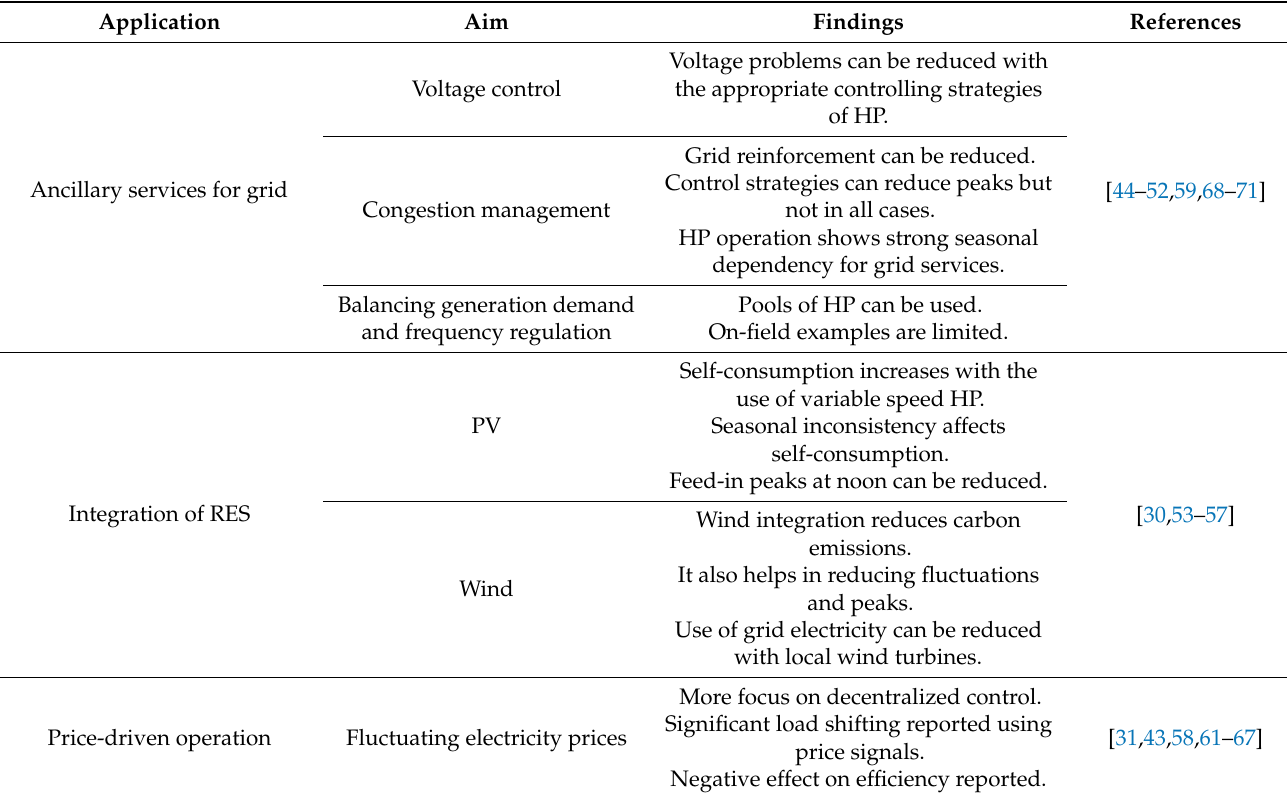
Table 2. Summary of the role of heat pumps in smart electricity